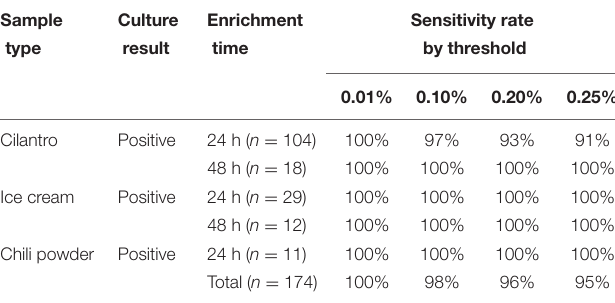
TABLE 2 | Salmonella enterica sensitivity rates by limit of detection threshold (0.01, 0.10, 0.20, and 0.25%).